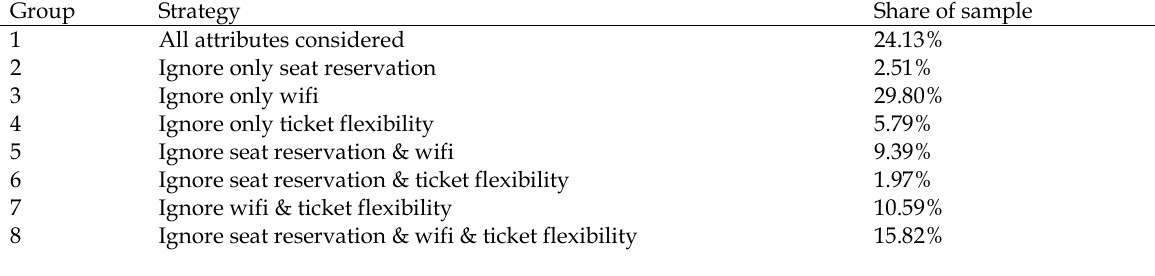
Classification of respondents on the basis of stated non-attendance